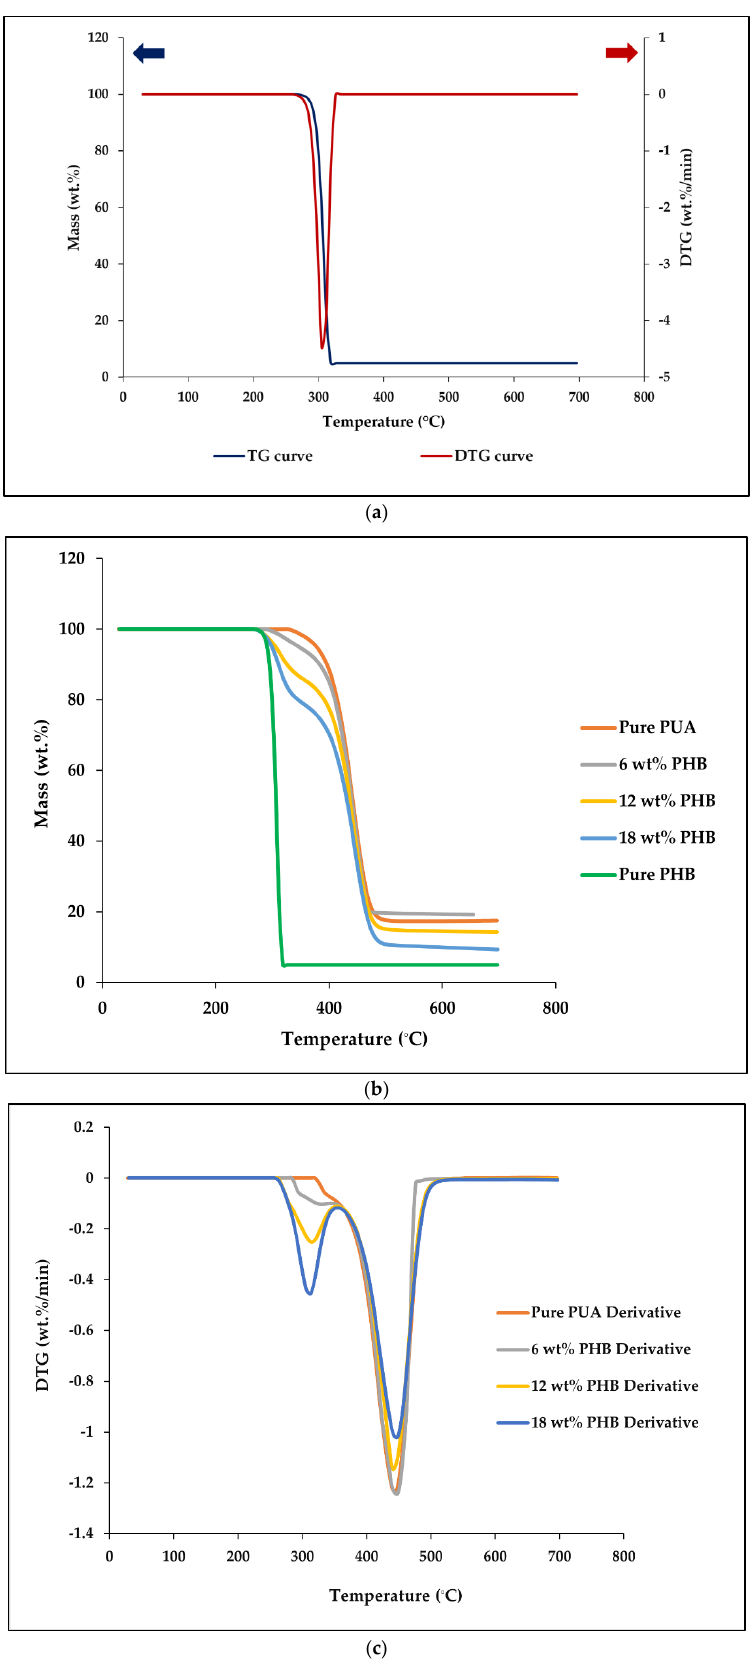
Figure 7. The thermal analysis of ( a ) TG curve and DTG curve of PHB powder; ( b ) TG curves of 3D- printed PHB/PUA blend composites; and ( c ) DTG curves of 3D-printed PHB/PUA blend composites. Other than that, the thermal stability of a polymer also could be determined by the residual weight of the TGA samples. Based on the results in Table 5 below, 3D-printed PHB/PUA compositions recorded a reduction in their residual weight, which was 19.67%, 14.85% and 10.56% for each of the 6, 12 and 18 wt.% blend compositions. These results present that the thermal stability of the blend compositions started to decrease, as thermal stability is the ability of a material to withstand the effect of heat that could affect the